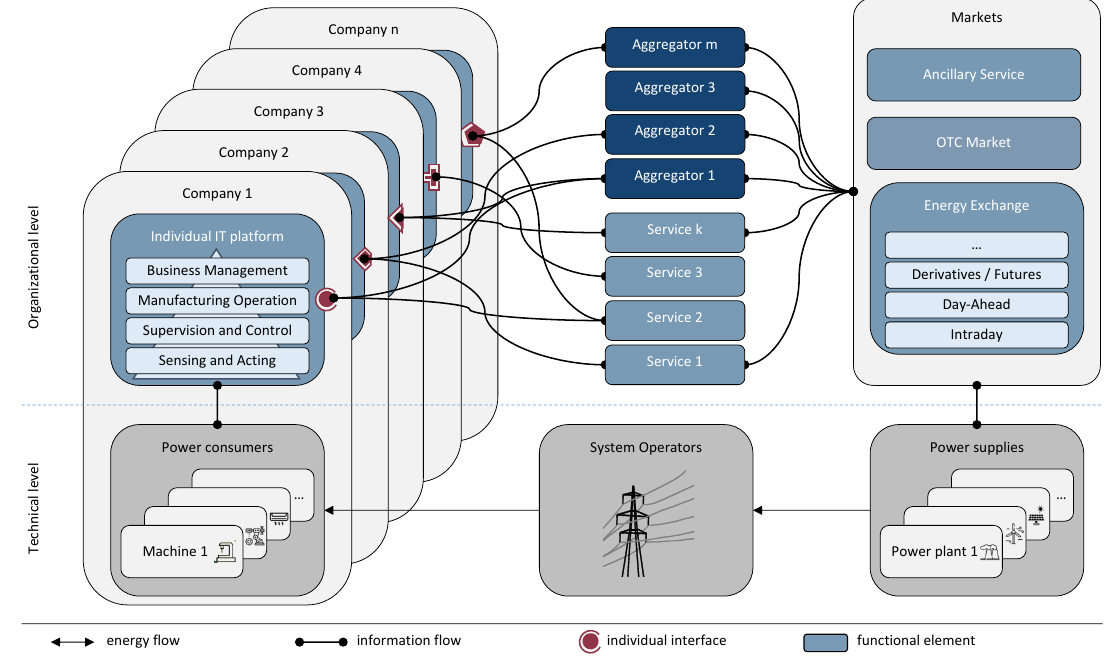
Figure 1. Current landscape of IT platforms, services, aggregators, and energy